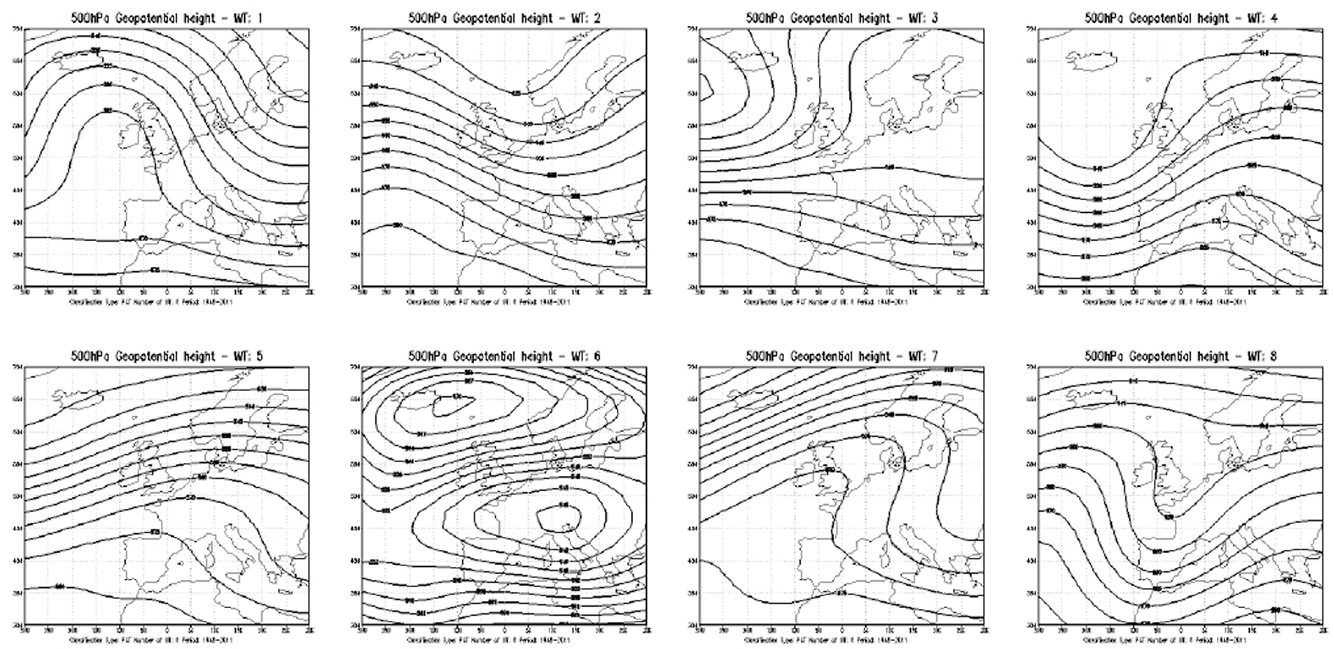
Fig 1. 500hPa geopotential height for each weather types (WT) classified by LAMMA-IBIMET for the period 1948 – 2011.